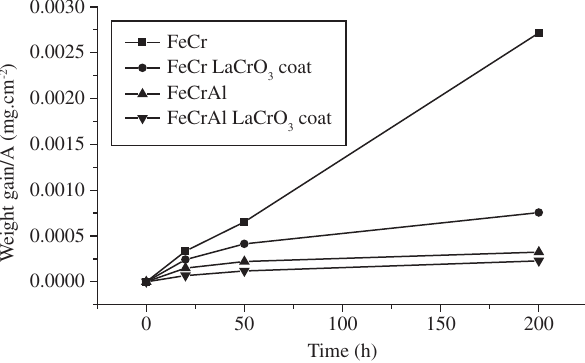
Figure 3. a) Cross section of Fe-20Cr after 200 hours of oxidation at 1000 °C; b) Surface of LaCrO coated Fe-20Cr after 200 hours of oxidation at 1000 °C; 3 and c) Cross section of